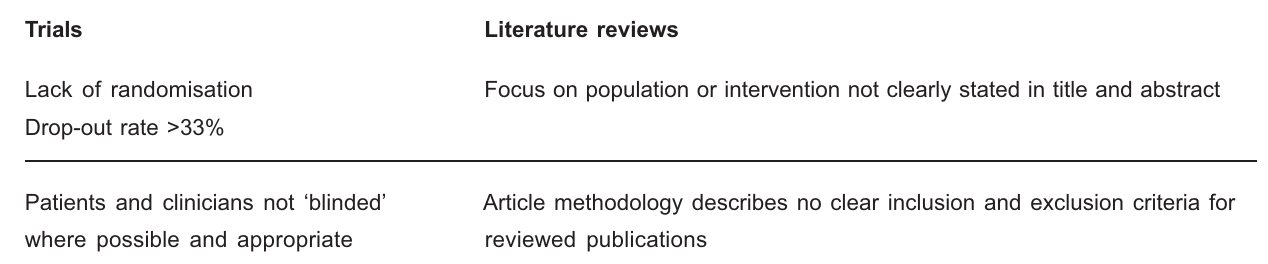
TABLE 1- Exclusion criteria for trials and literature